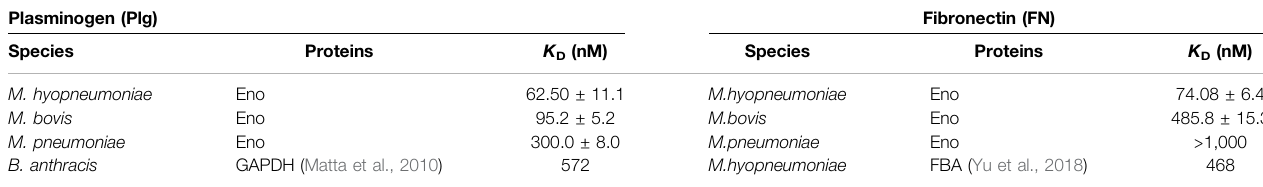
TABLE 3 | Binding af fi nities of plasminogen/ fi bronectin with different enolases determined by SPR. Plasminogen